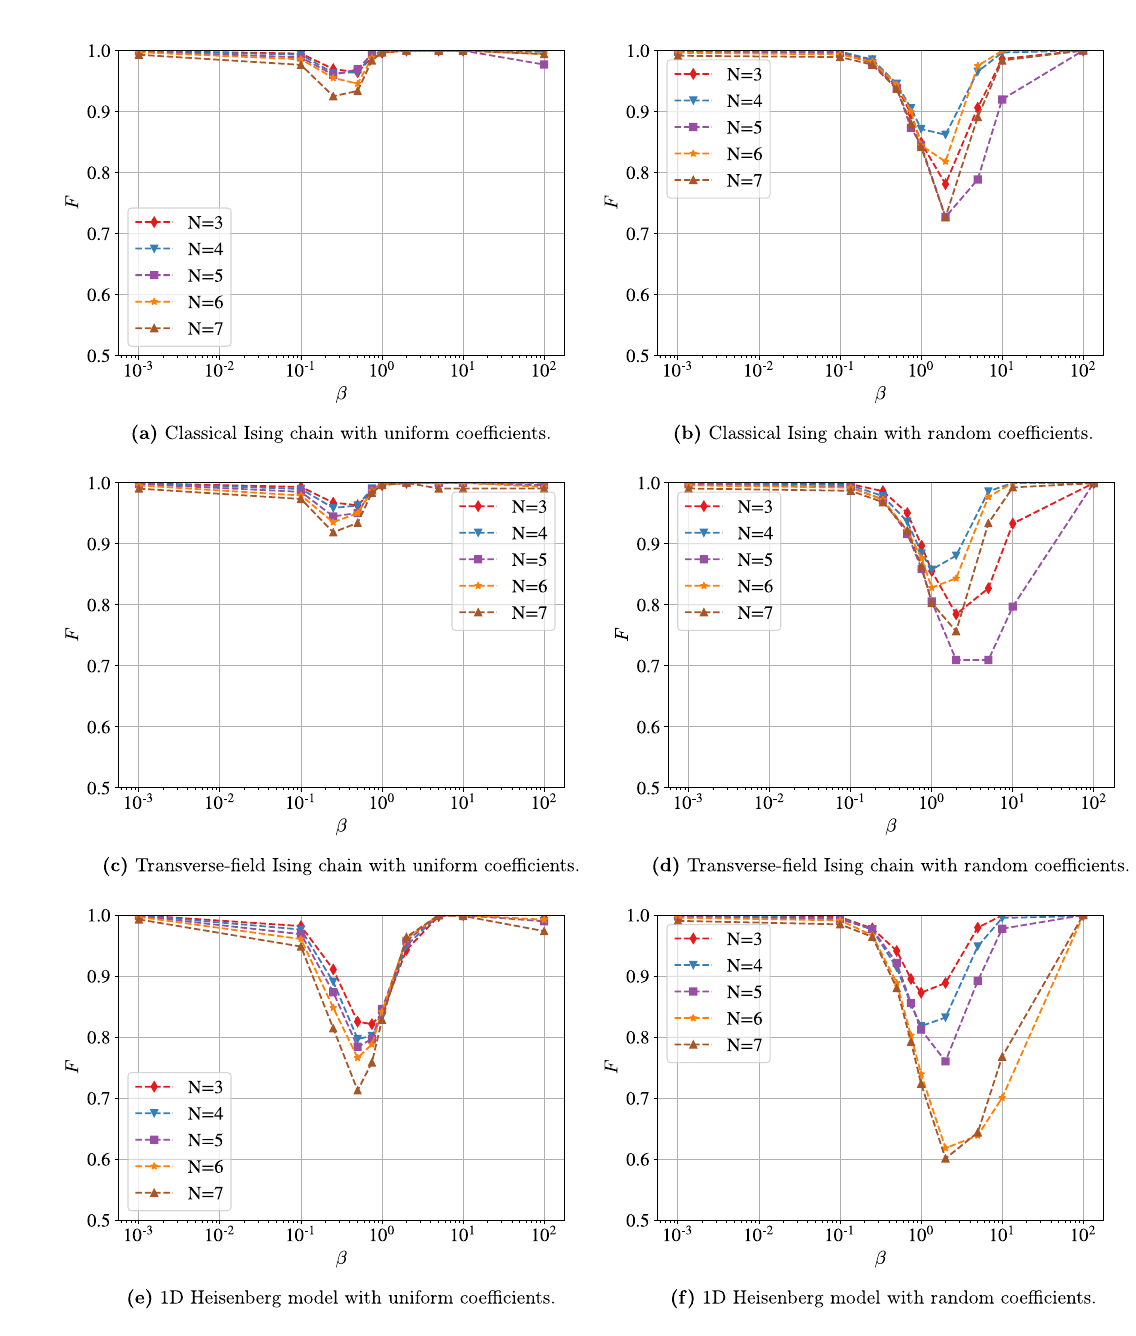
Figure 4. Fidelities obtained using NAVQT as a function of the inverse temperature β , for various